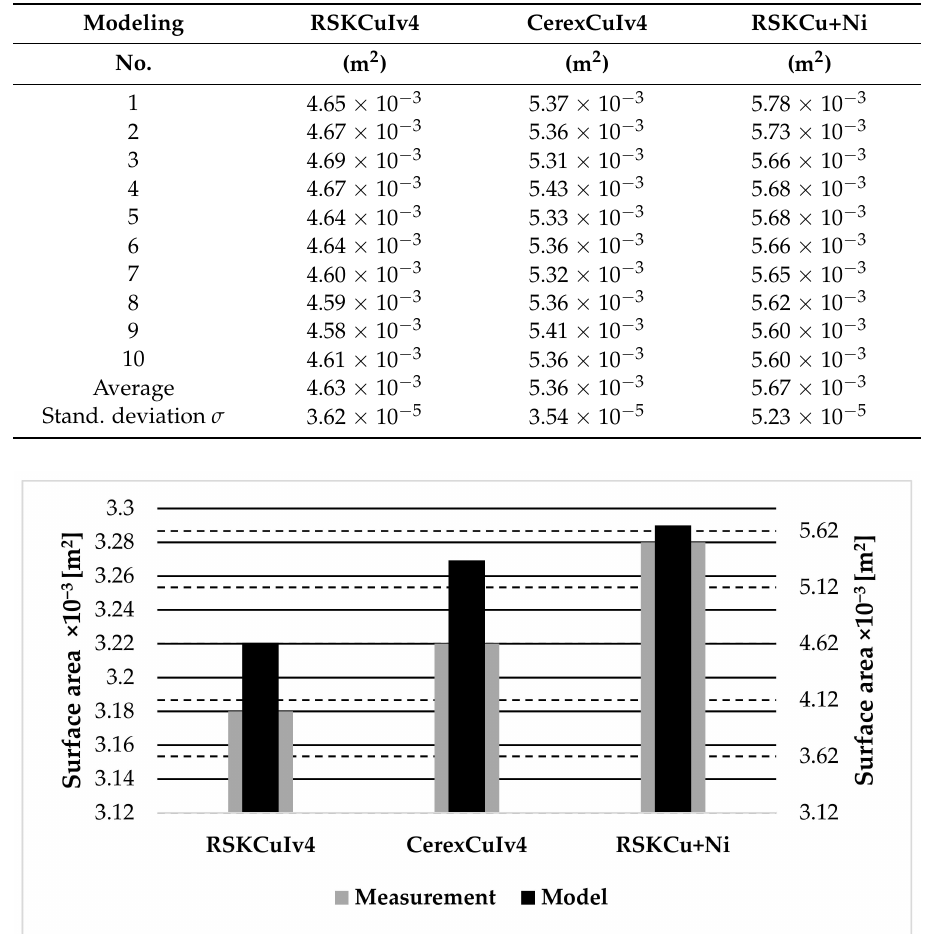
Figure 15. Comparison of modeling and measurement results of the surface area of samples.